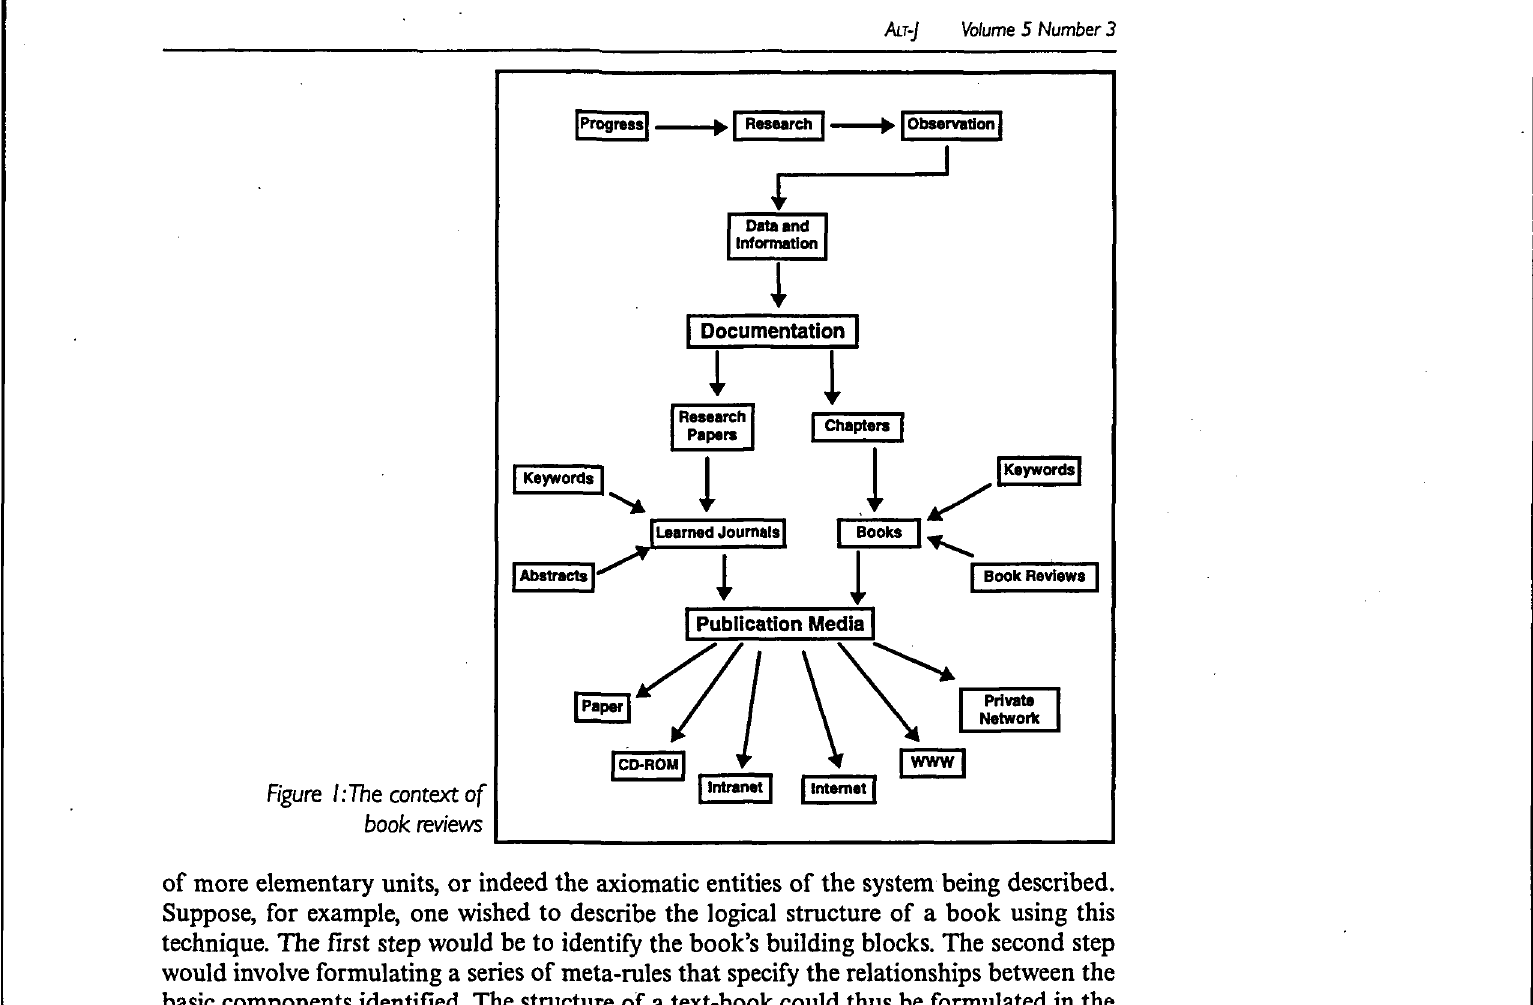
Figure I:The context